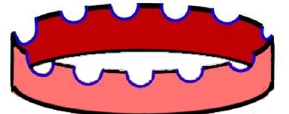
Figure 3. Euclidean path integral defining a “discretization” operator that maps from the Hilbert space of a CFT on S 1 to the Hilbert space of an associated BCFT-bit system. For an accurate approximation, the “gaps” on the upper boundary should be taken small compared to the remaining